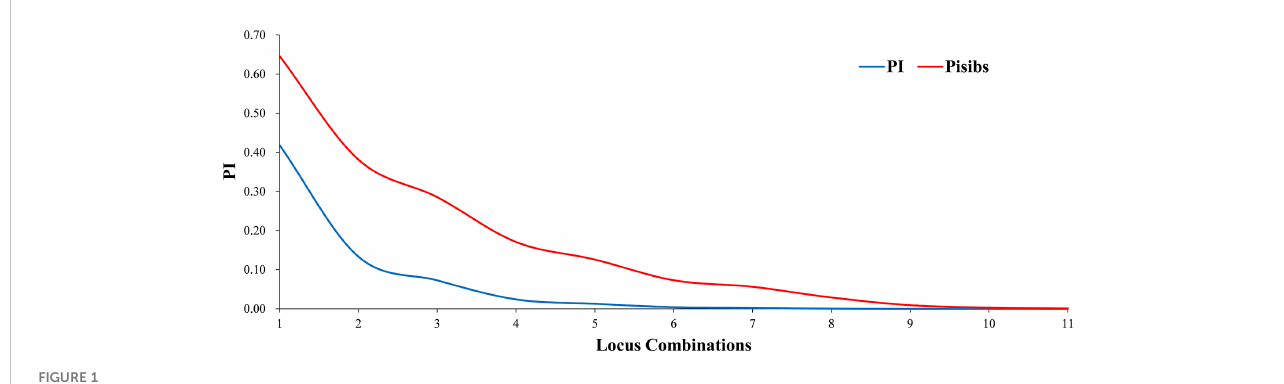
FIGURE 1 Identi fi cation ability of SSR markers in Korean pine